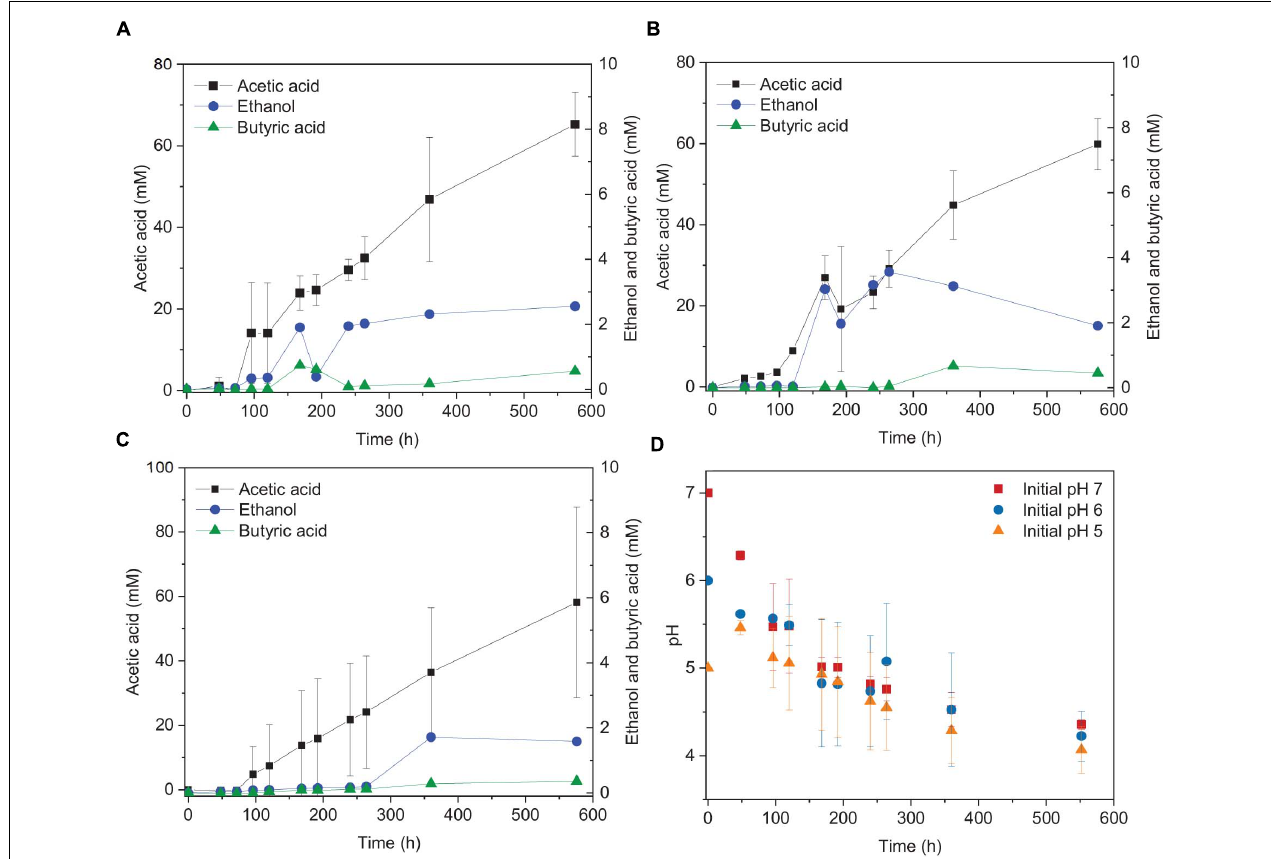
FIGURE 1 | Acetic acid and ethanol production from H 2 /CO 2 by heat-treated granular sludge at 25 ◦ C at (A) pH 7, (B) pH 6, (C) pH 5, and (D) change of pH over time.